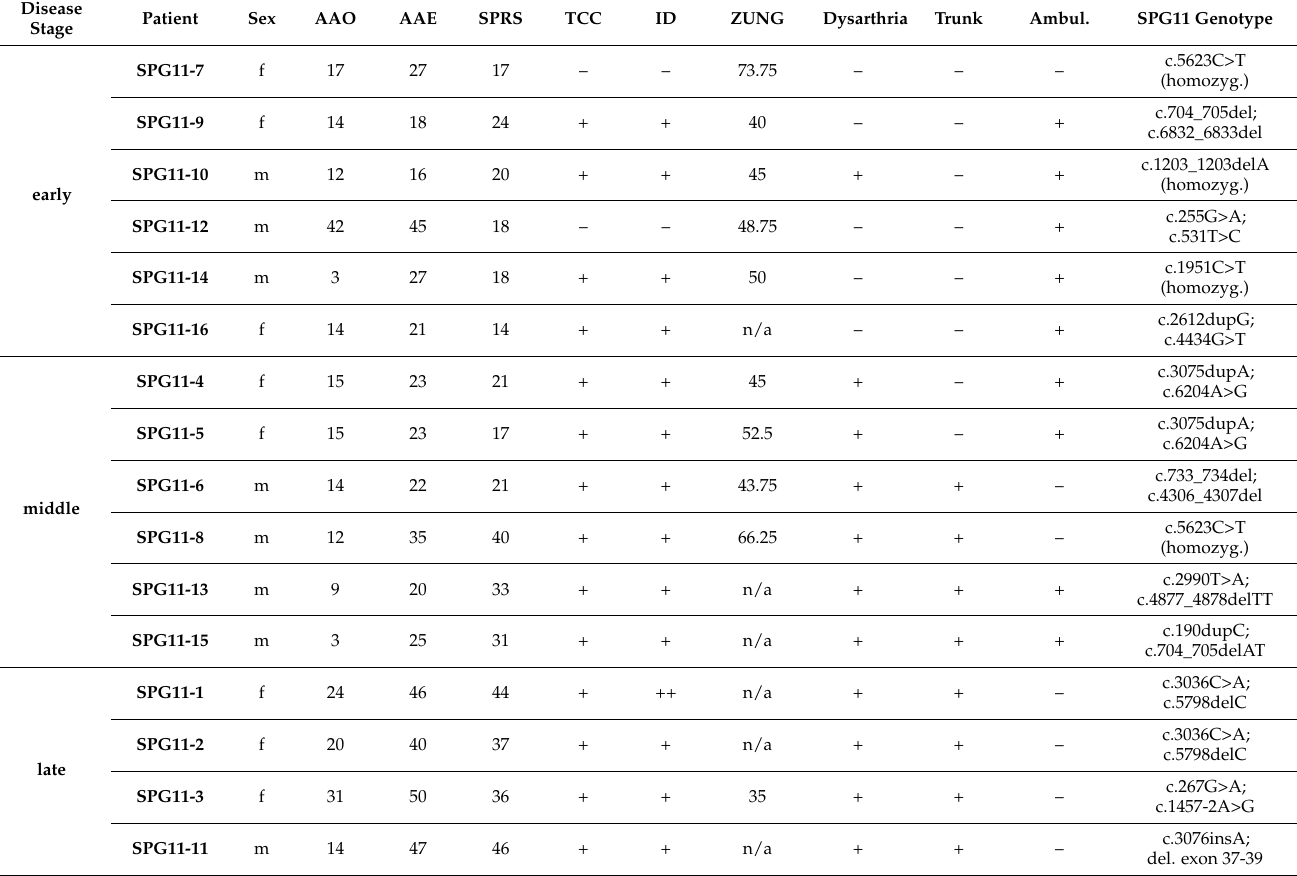
Table 2. Demographic and disease-related characteristics of the SPG11 patient